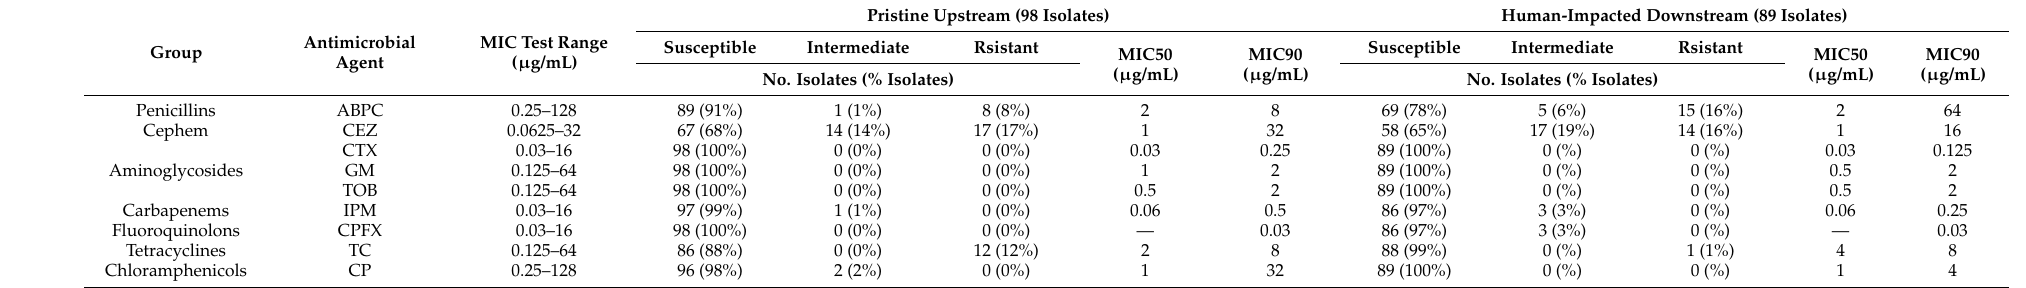
Table 3. Antibiotic susceptibility of E. coli isolates from Kaeda